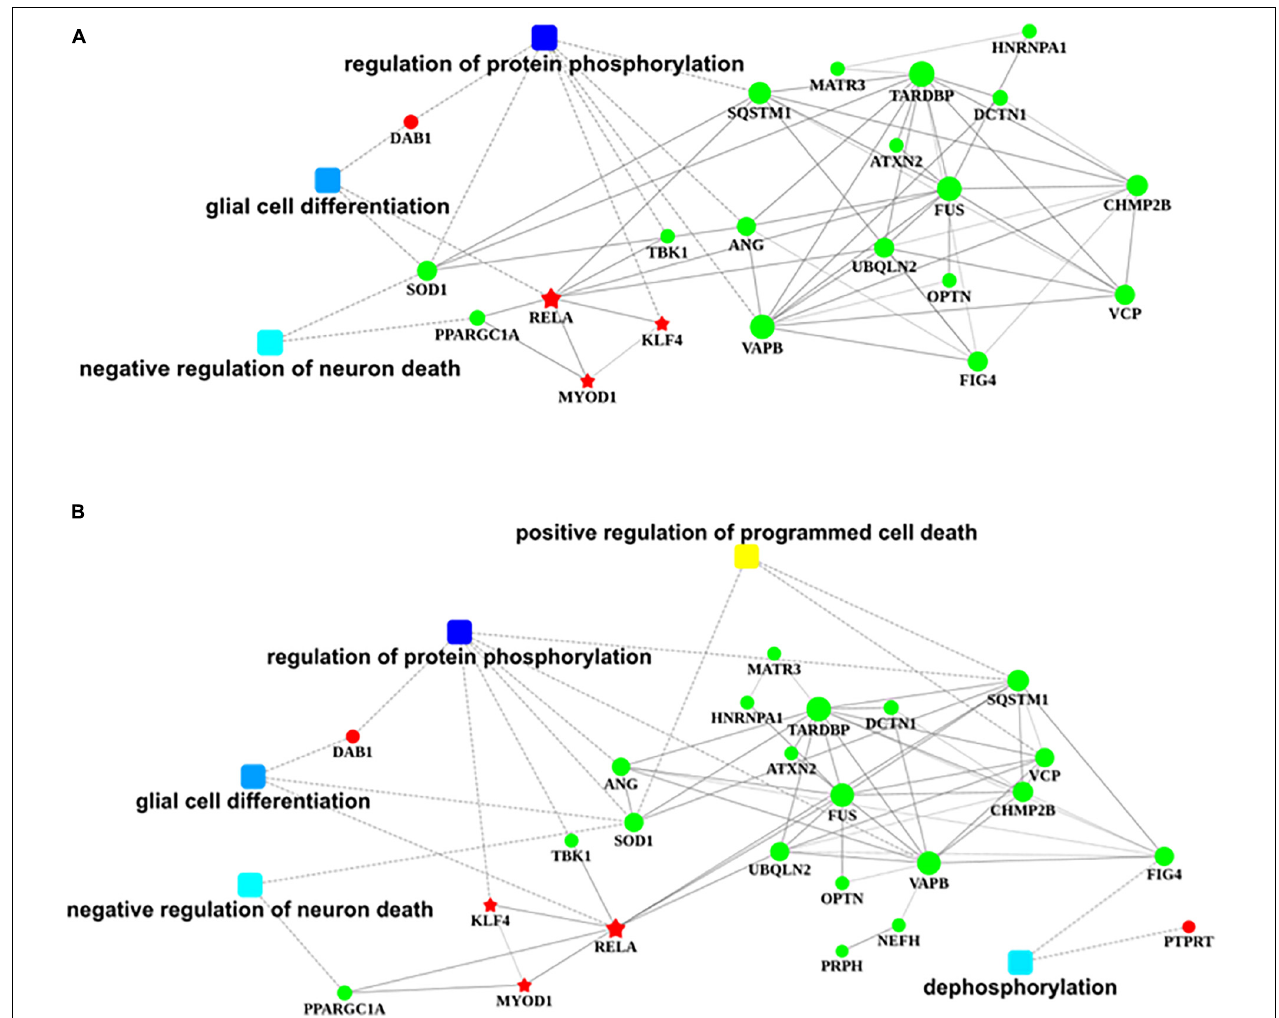
FIGURE 8 | Regulatory networks of DAB1 and PTPRT . (A,B) Nervous system regulatory networks of transcription factors binding to the promoter region of DAB1 gene (A) and PTPRT gene (B) and genes related to ALS (OMIM 105400). The red pentagon represents transcription factors; the green node represents predisposing genes; squares represent biological processes; and lines indicate the relationships between transcription factors, genes, and biological processes. ALS, amyotrophic lateral